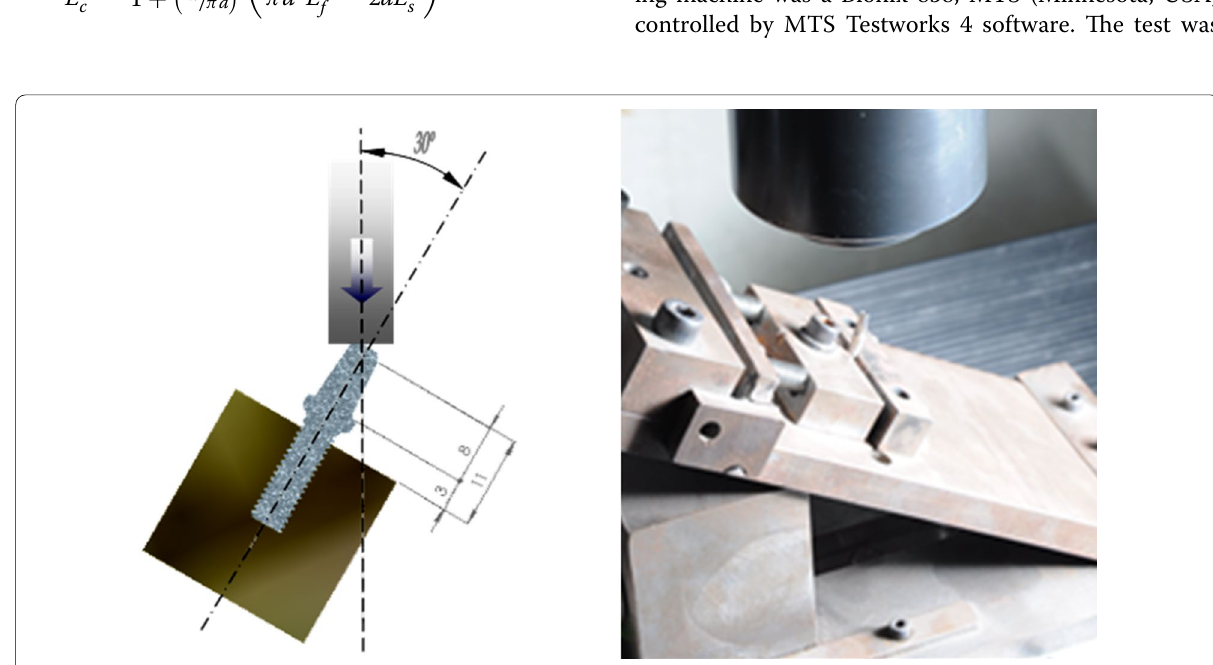
Fig. 3 Mechanical tests system according to the ISO